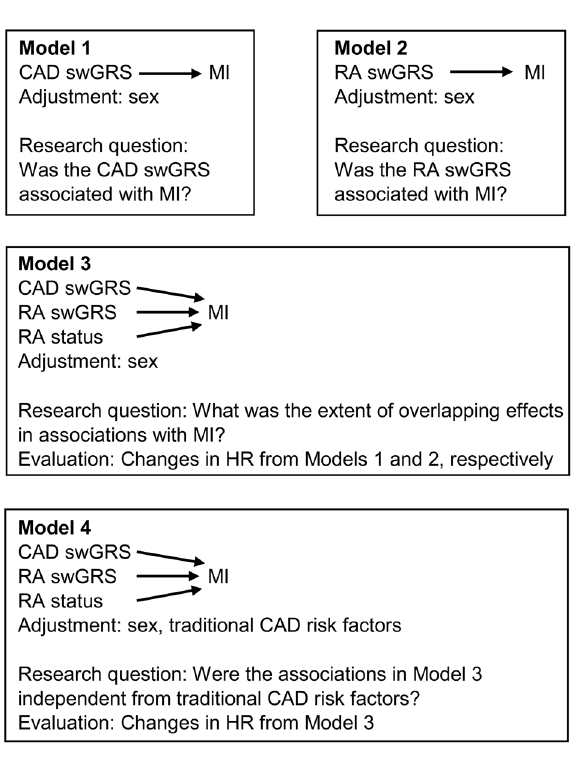
Figure 2. Cox regression analysis outline. Variables and research questions for the stepwise Cox regression analysis. Age was the time variable and thereby participants were compared with other participants of their own age. Traditional CAD risk factors in Model 4 were smoking, hypertension, total cholesterol, body mass index, self-reported previous cardiovascular disease, and diabetes. Abbreviations: CAD: coronary artery disease; MI: myocardial infarction; RA: rheumatoid arthritis; swGRS: standardized, weighted genetic risk